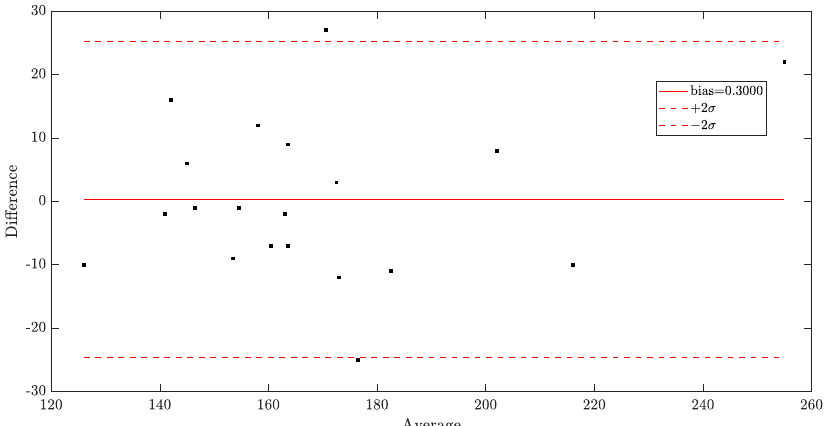
Figure 8. Statistical results of the REX test. The differences in subject performance with or without transmission data. The bias was 0.3500, and the standard deviation of the difference was 7.6590, as defined in [29].